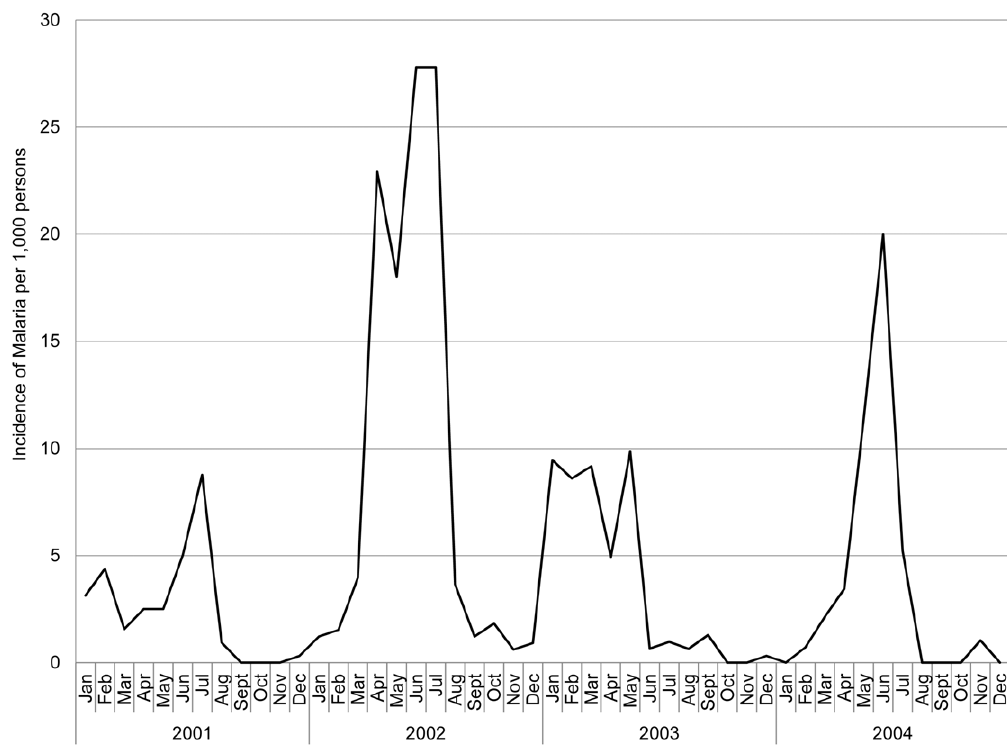
Figure 1. Malaria incidence in the highland area of Kipsamoite, 2001–2004.